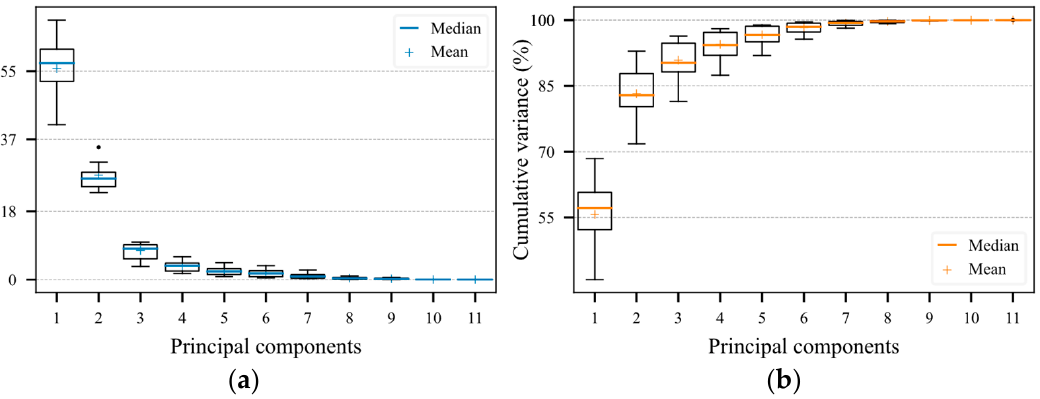
Figure 7. Distribution of the variance of the five transformers on the principal components. ( a ) Variance on each component. ( b ) Accumulated variance up to the corresponding principal component.